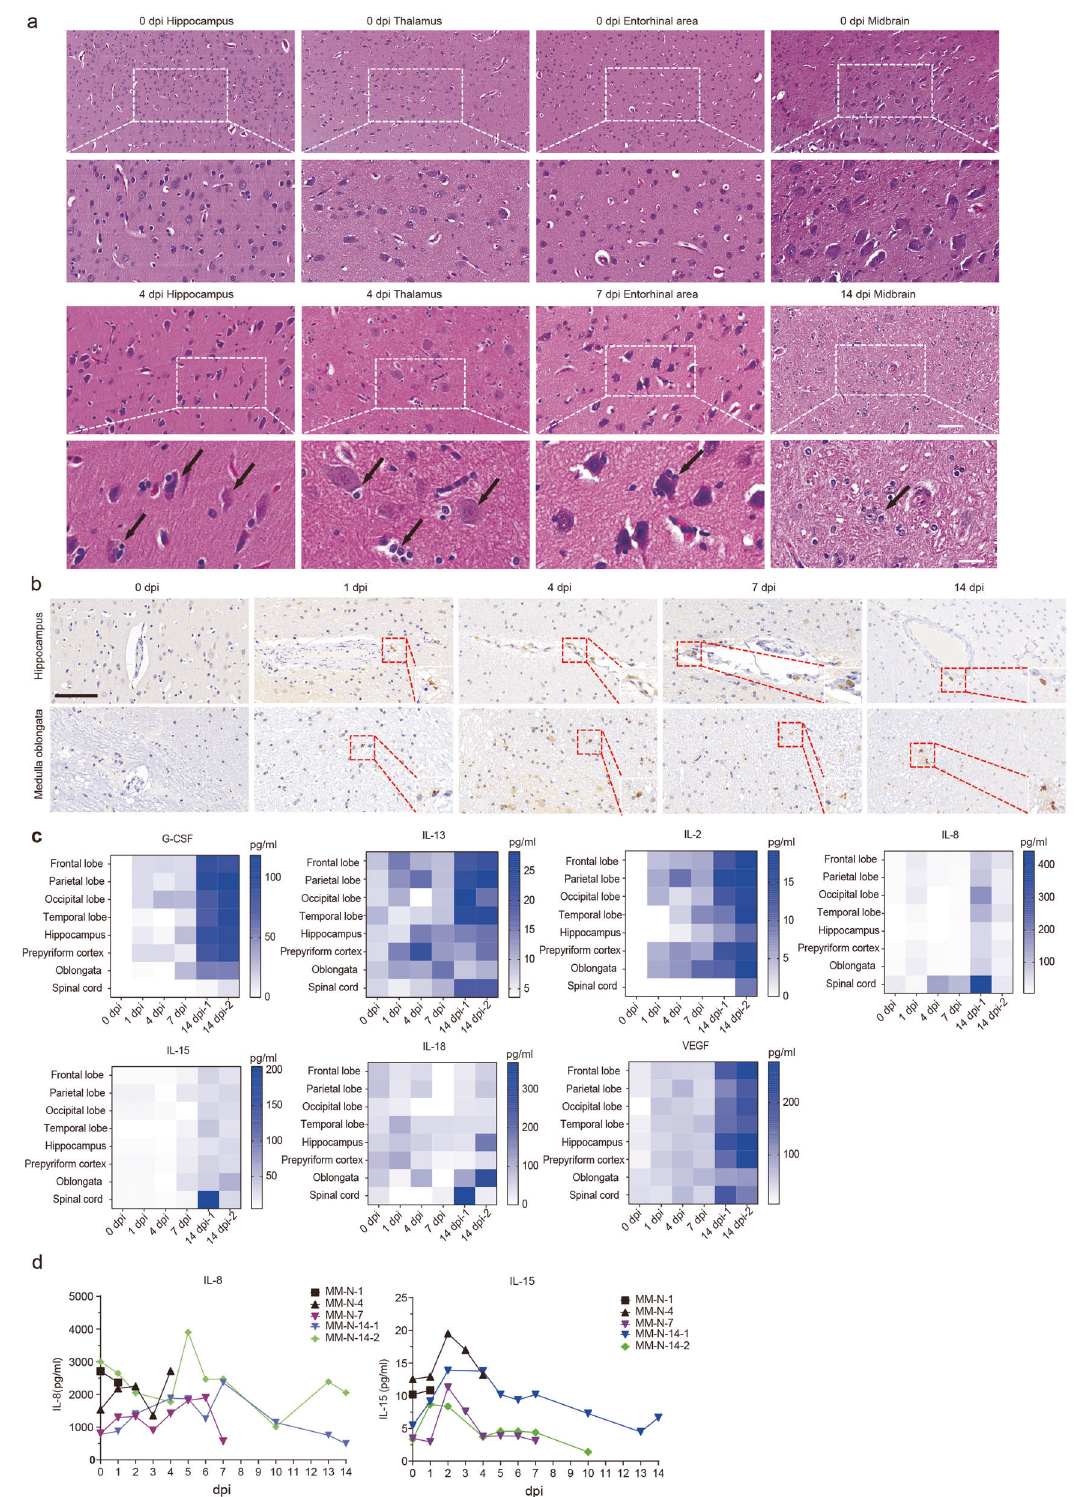
Fig. 2 SARS-CoV-2 invasion results in in fl ammation and pathological changes in the CNS. a Hematoxylin and eosin (H&E) staining showed that intranasal SARS-CoV-2 inoculation caused different degrees of neuronal death, glial hyperplasia, and edema and perivascular in fl ammatory cell in fi ltration in the brain compared with PBS control (0 dpi), which is described in the text. Scale bar (upper panel), 50 μ m; scale bar (lower panel), 20 μ m.(b) Immunochemistry (IHC) analysis of CD68-positive cells in the brains of rhesus macaques on 0, 1, 4, 7 and 14 dpi. Each data point represents an independent fi eld of view from slides subjected to IHC. Arrow, positive staining. Scale bar, 100 μ m. c Concentrations of in fl ammatory cytokines in the brains of rhesus macaques infected with SARS-CoV-2. d Concentrations of in fl ammatory cytokines in the serum of rhesus macaques infected with